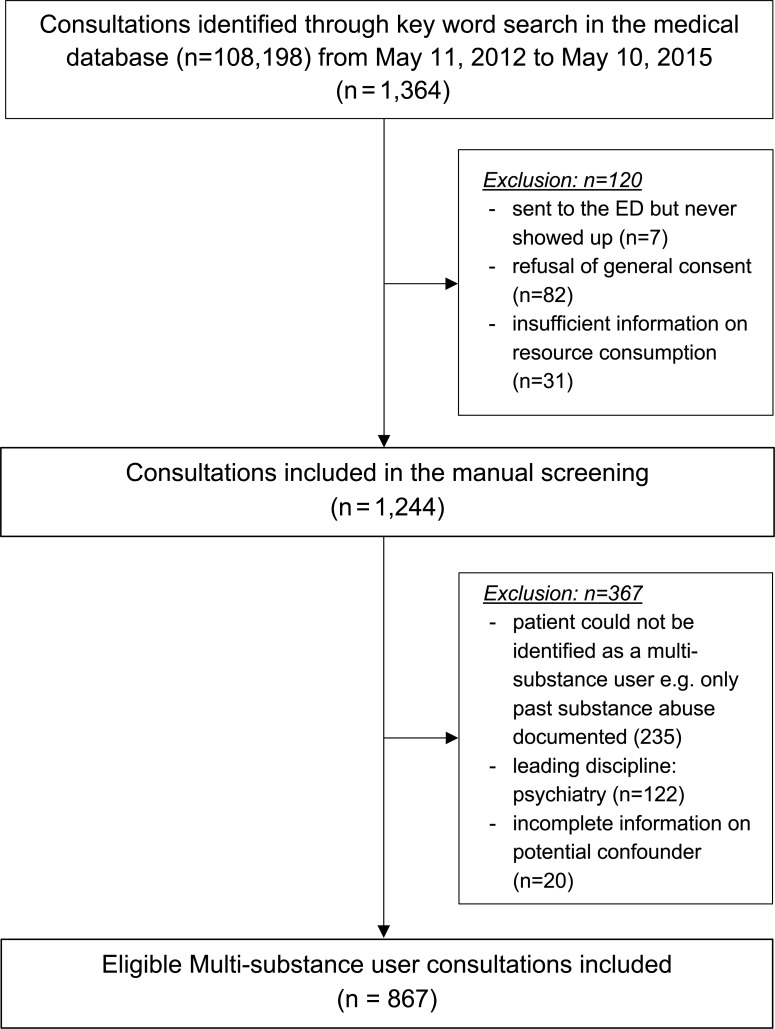
Flowchart of the study.